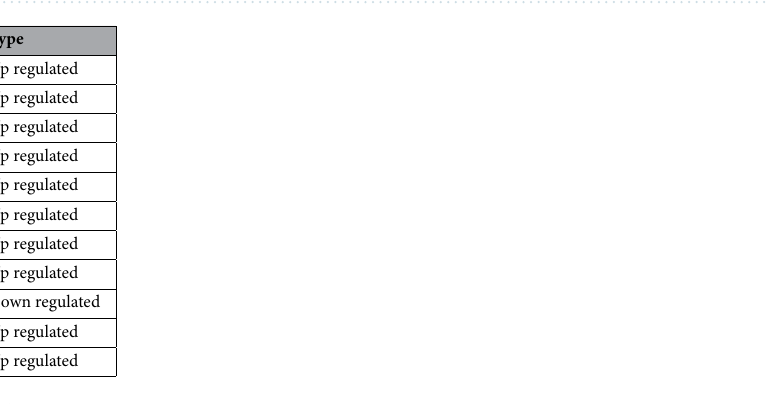
Table 2. Correlation coefficients of 11 optimal genes in necroptosis-related prognostic